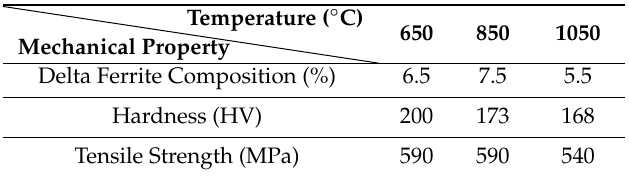
Table 6. Delta ferrite composition and mechanical properties of austenitic stainless steel at di ff erent annealing temperatures in the range of 650–1050 ◦ C [57].